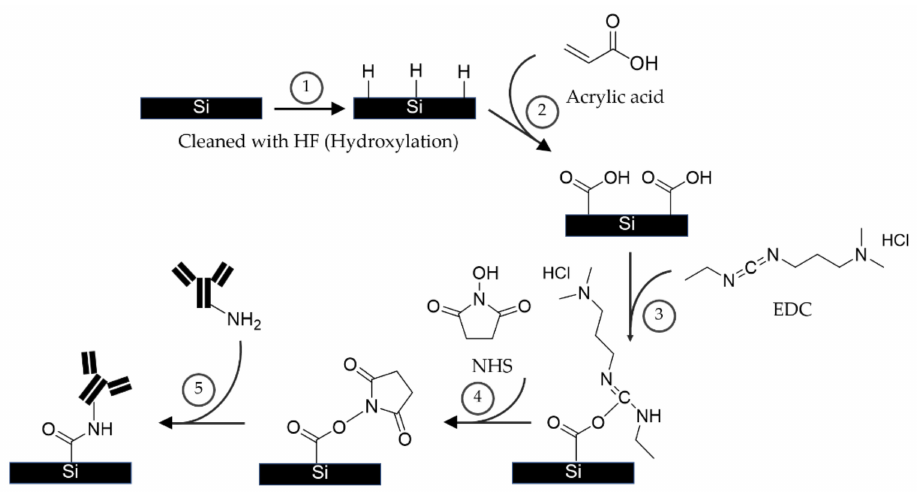
Figure 2. The procedure for the conventional EDC/NHS